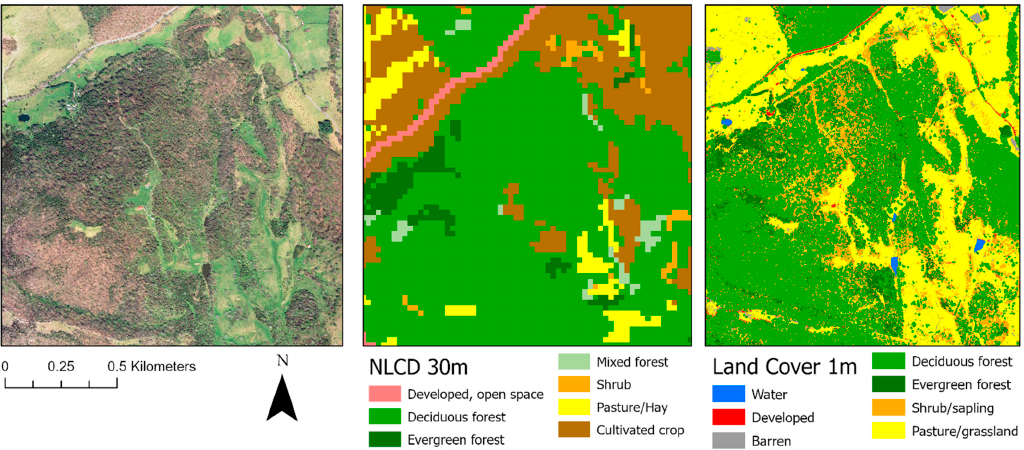
Figure 4. Example landscape with scattered shrub/sapling cover as represented by NAIP imagery ( left ), a 30 m resolution National Land Cover Data (NLCD, middle ), and our 1 m custom classifica- tion ( right ).